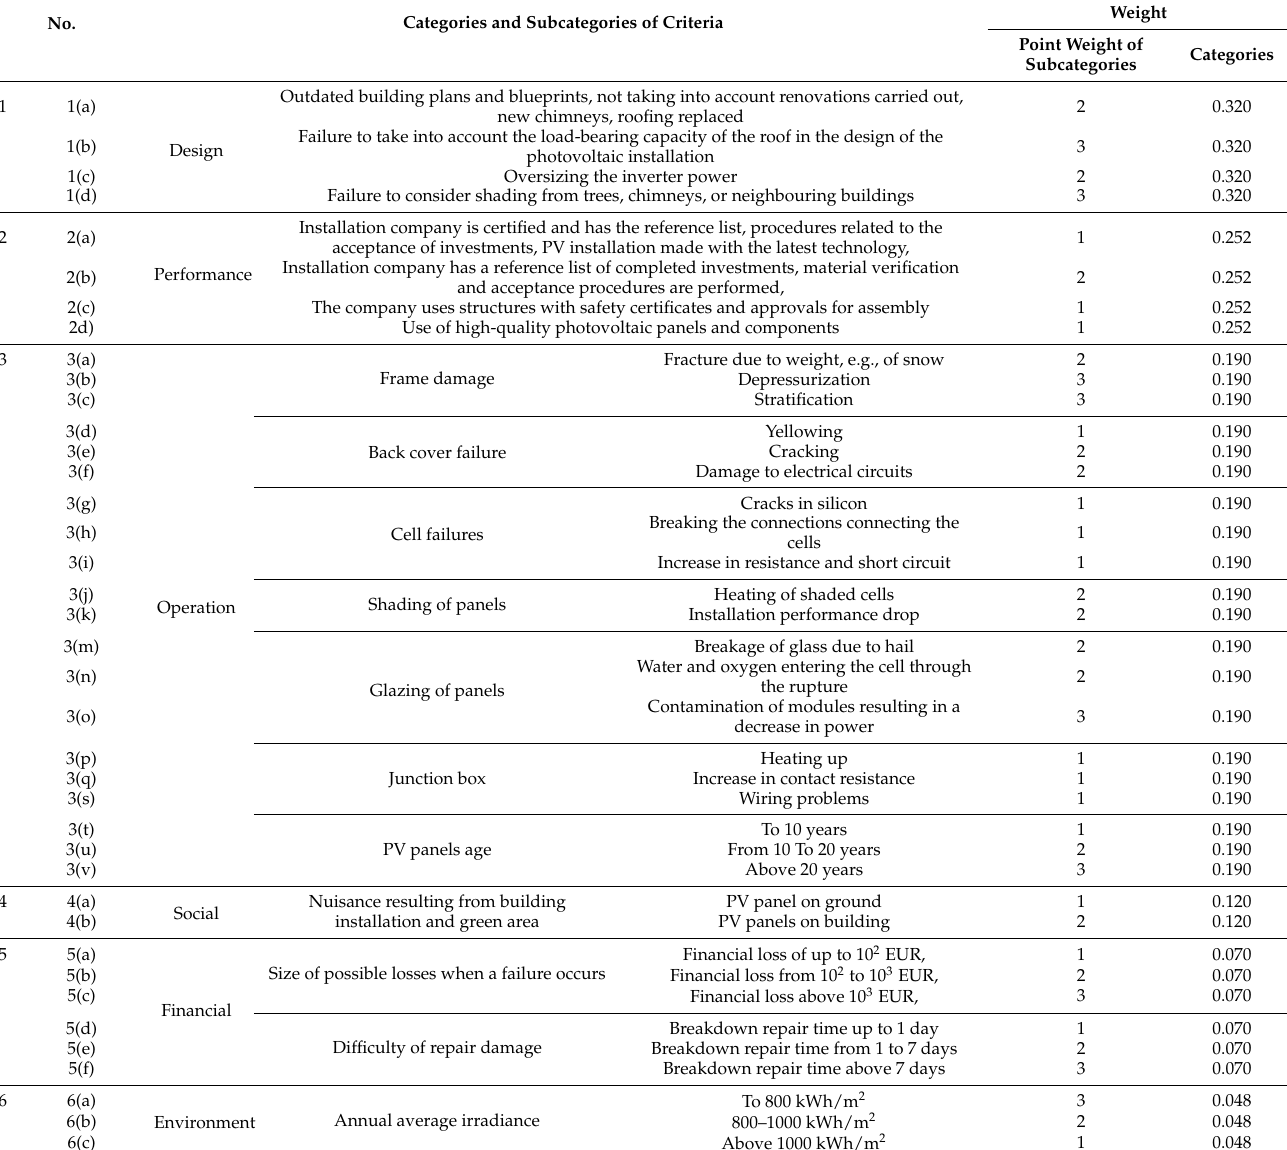
Table 6. A characterization of the PV